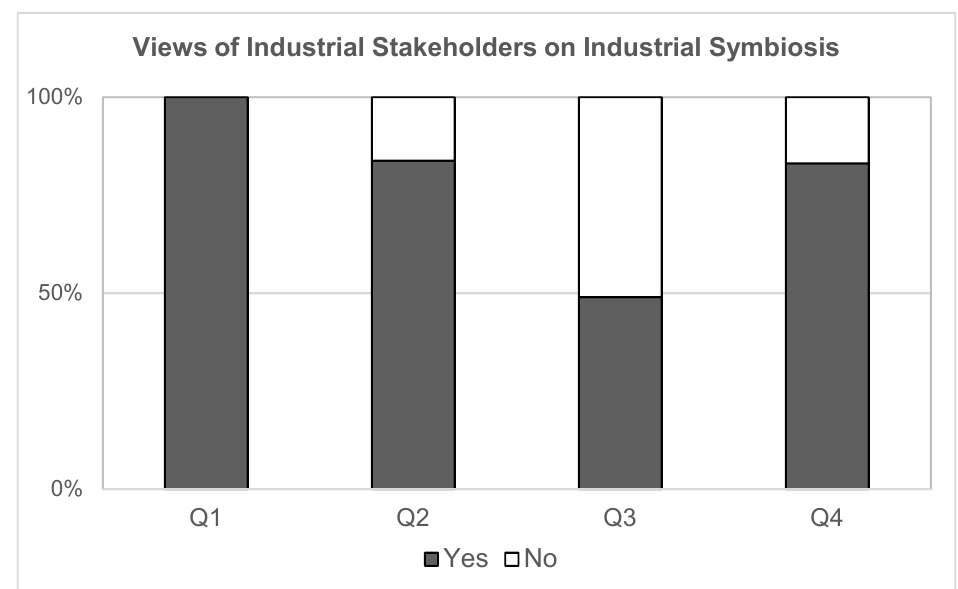
Figure 5. Views on circular economy and industrial symbiosis of the SWAN industrial ecosystem in Cyprus.